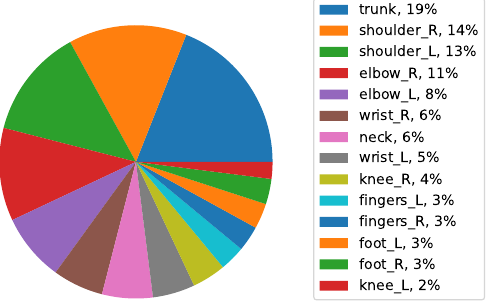
Figure 13. Average FWA of body parts in seniority over